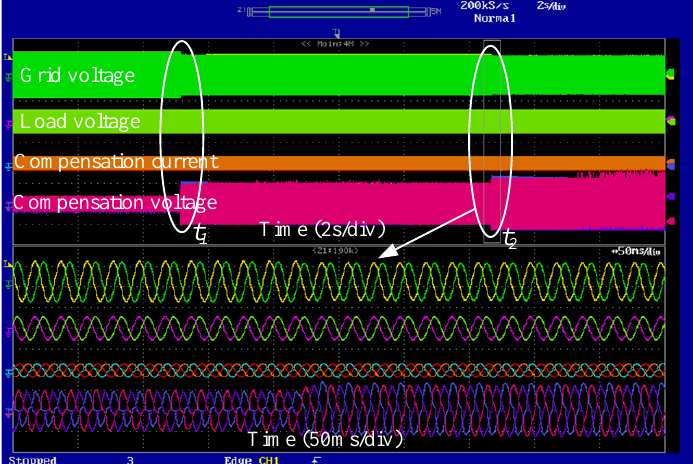
Figure 25. Experimental result of the compensation module.